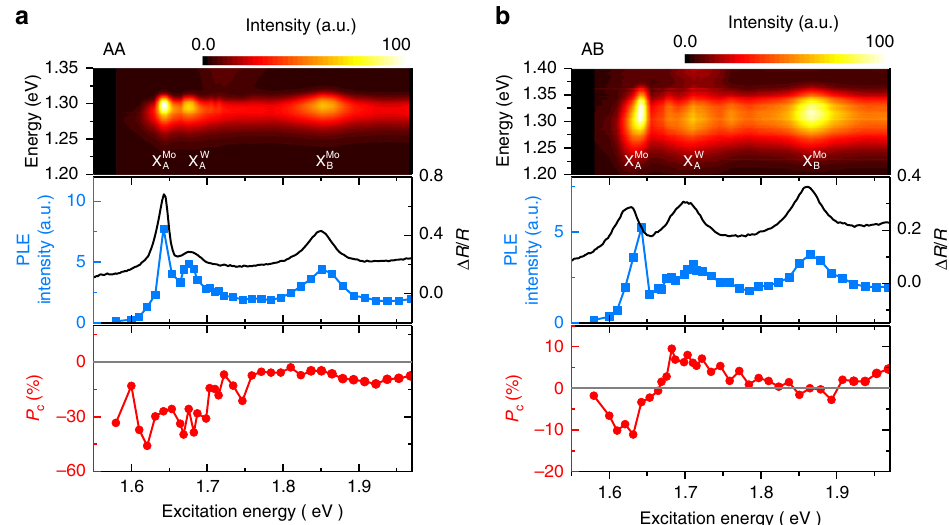
Fig. 4 Excitation energy dependence of PL intensity and circular polarization of interlayer excitons. a AA stacking. b AB stacking. Top: contour plots for the X I PL spectra using different excitation energies. Middle: the corresponding PLE spectra. The differential re fl ectance spectra Δ R / R are also shown for comparison. Bottom: the degree of circular polarization P C as a function of excitation energy. X Mo and WSe 2 , respectively. The X W peak measured by PLE and differential re fl ectance Δ R / R is dominated by trion A